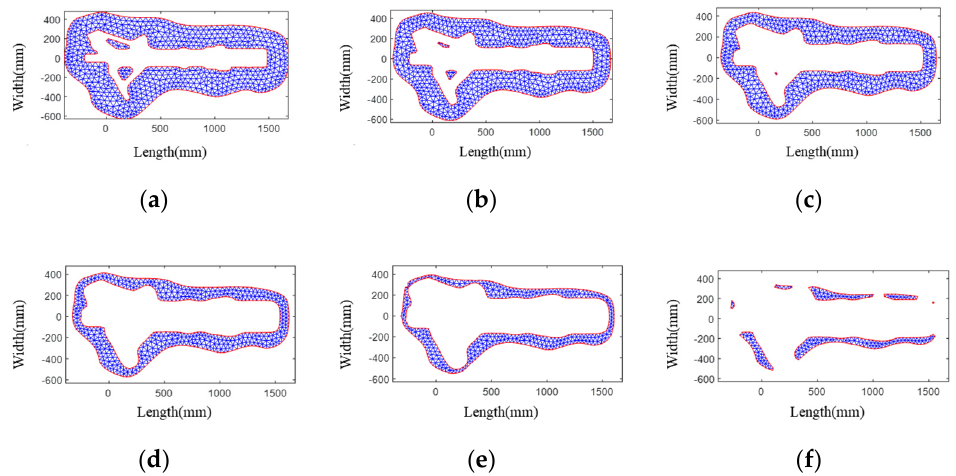
Figure 7. Contours and mesh with different offset distances generated by using FEM: ( a ) 10 mm; ( b ) 30 mm; ( c ) 50 mm; ( d ) 70 mm; ( e ) 90 mm; ( f ) 110 mm. ( b ) 30 mm; ( c ) 50 mm; ( d ) 70 mm; ( e ) 90 mm; ( f ) 110 mm.